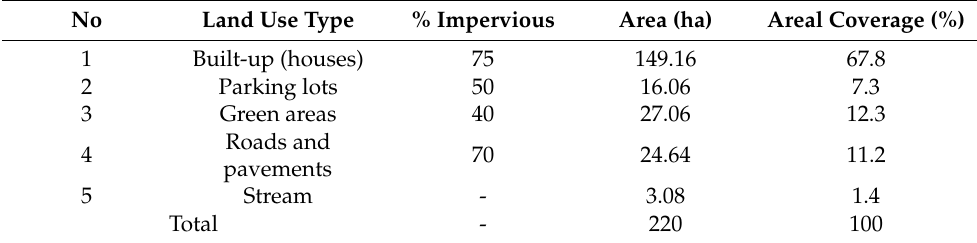
Table 5. Area coverage of different LID